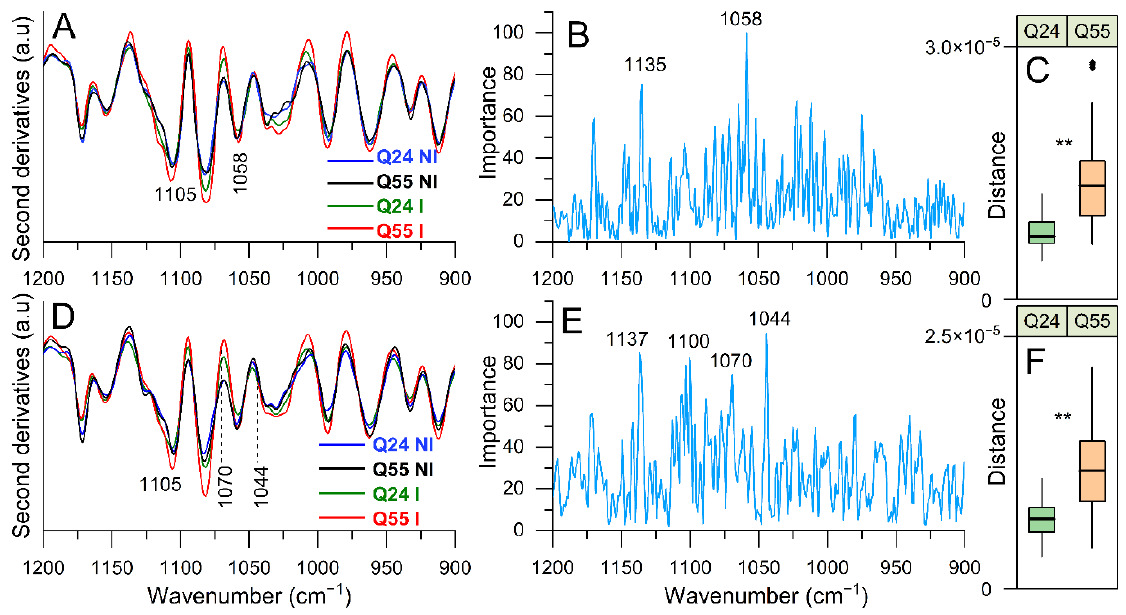
Figure 7. FTIR analysis in the 1200–900 cm − 1 spectral range. The second derivatives of representative FTIR spectra, identified by PLS-DA, of E. coli cells expressing ATX3-Q24 and ATX3-Q55 at 5 ( A ) and 8 ( D ) hours of induction, and of NI cells are reported. In ( B ) (5 h) and ( E ) (8 h), the loading plots representing the spectral components more relevant for the discrimination between the classes are displayed. In ( C ) (5 h) and ( F ) (8 h), the distribution of distances between I and NI is represented as box plots, as in Figure 4. The reported spectroscopic analyses were performed on spectra from three independent experiments, where 5–7 spectra were collected for each condition in each experiment. **: p -value < 0.01.